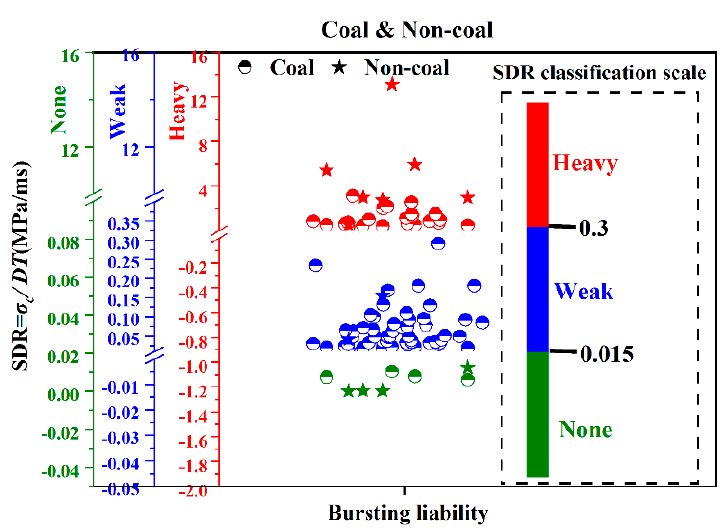
Figure 10. Bee colony map of the brittleness index B.